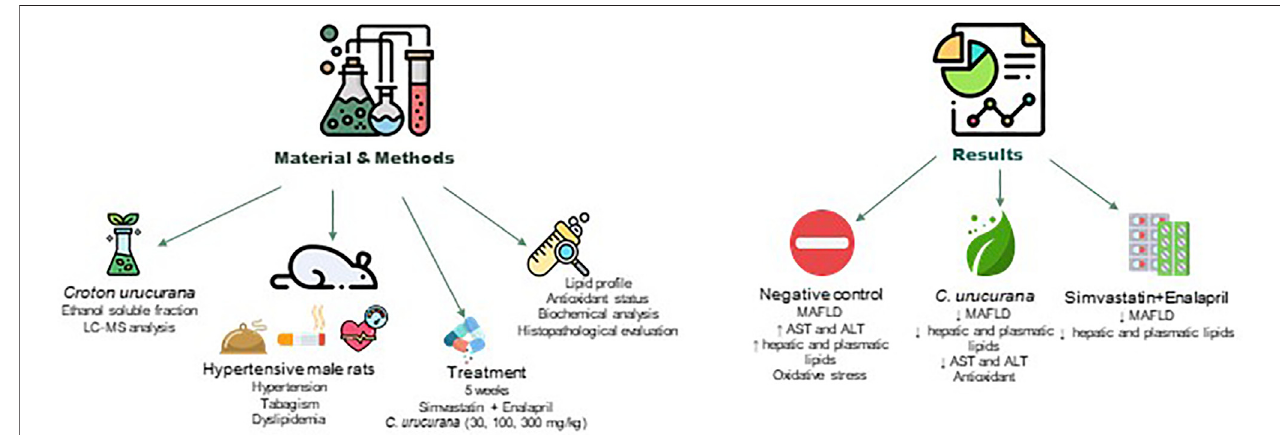
FIGURE 5 | Summary of hepatoprotective effects of Croton urucurana using an experimental model that employed a combination of hypertension, dyslipidemia, and exposure to tobacco